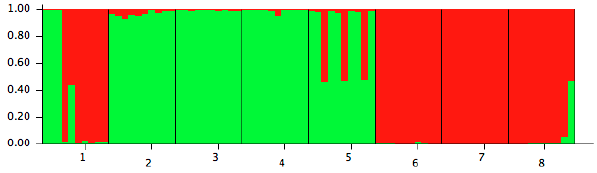
Figure 8. STRUCTURE plot of Z. Jujube populations based on k =